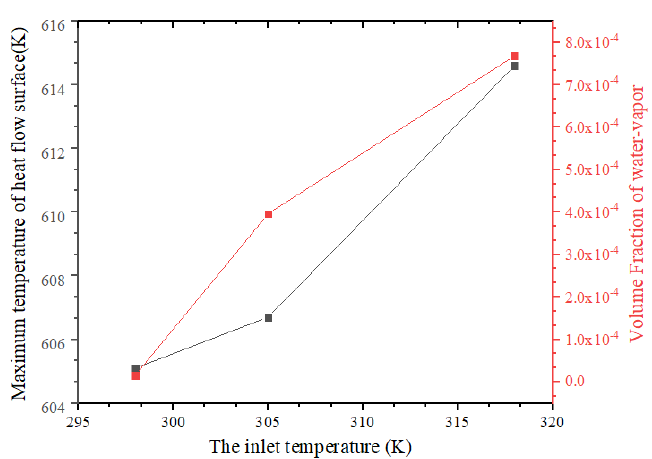
Figure 13. Maximum temperature and maximum bubble volume fraction with different inlet temperatures.